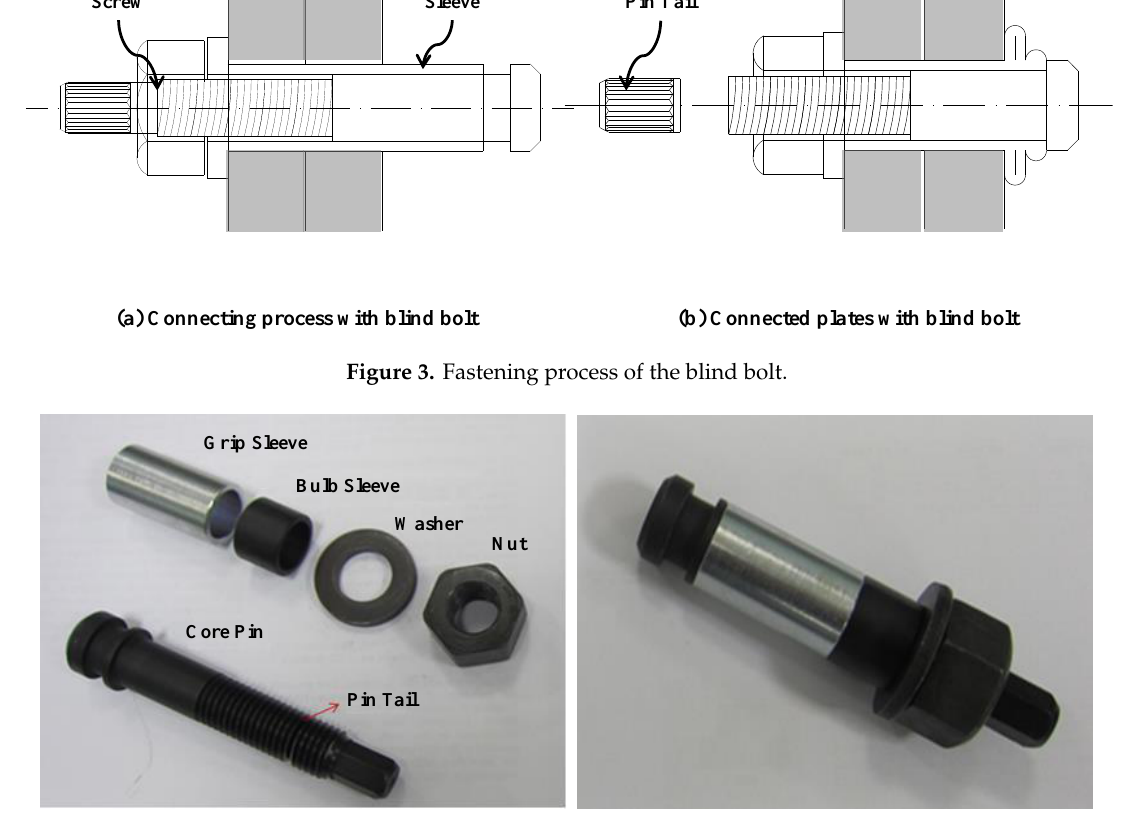
Figure 4. Blind bolt details.